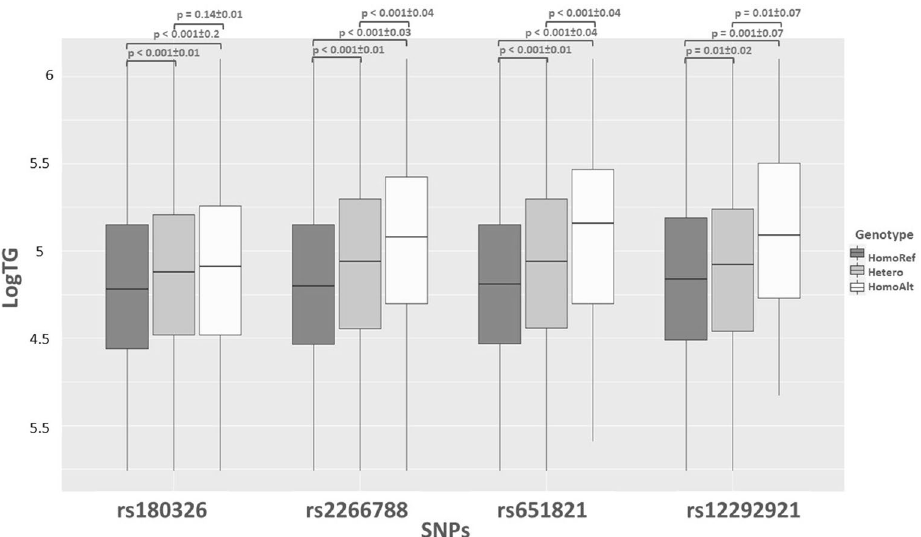
Figure 3. Log of TG levels (LogTG) against the four notable significant SNPs. This figure also shows TG levels by increasing risk alleles in each genotype type in subjects. The p-values and standard errors for between genotypes can be found (p-value ± S.E).